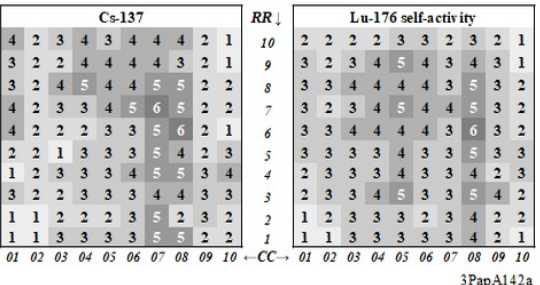
Figure 4. Array maps representing the crystal-pixel’s 2-D distributions per pulse-height cluster from Cs-137 ( left ) and Lu-176 self-activity ( right ) data-takings. Bin-sizes of 4.8-, and 4.0-charge-units were chosen, respectively, for clustering the Qnet values from each irradiation into five or six groups, which makes the distributions comparable with each other. The coordinates of the pixels in the array were described by using the RRCC codes.